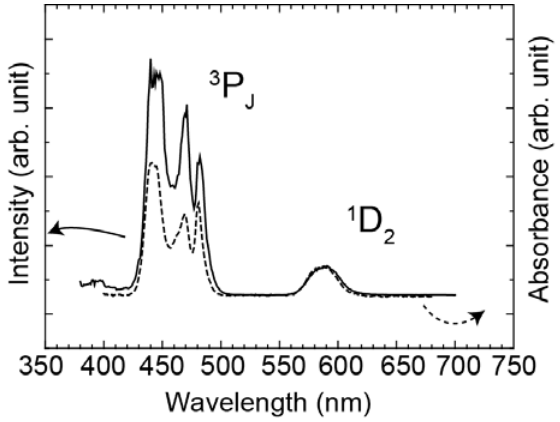
Figure 4. Excitation spectrum of Yb 3+ 1  m luminescence of the Pr 3+ -Yb 3+ codoped glass (solid line) and absorption spectrum of the Pr 3+ doped glass (dotted